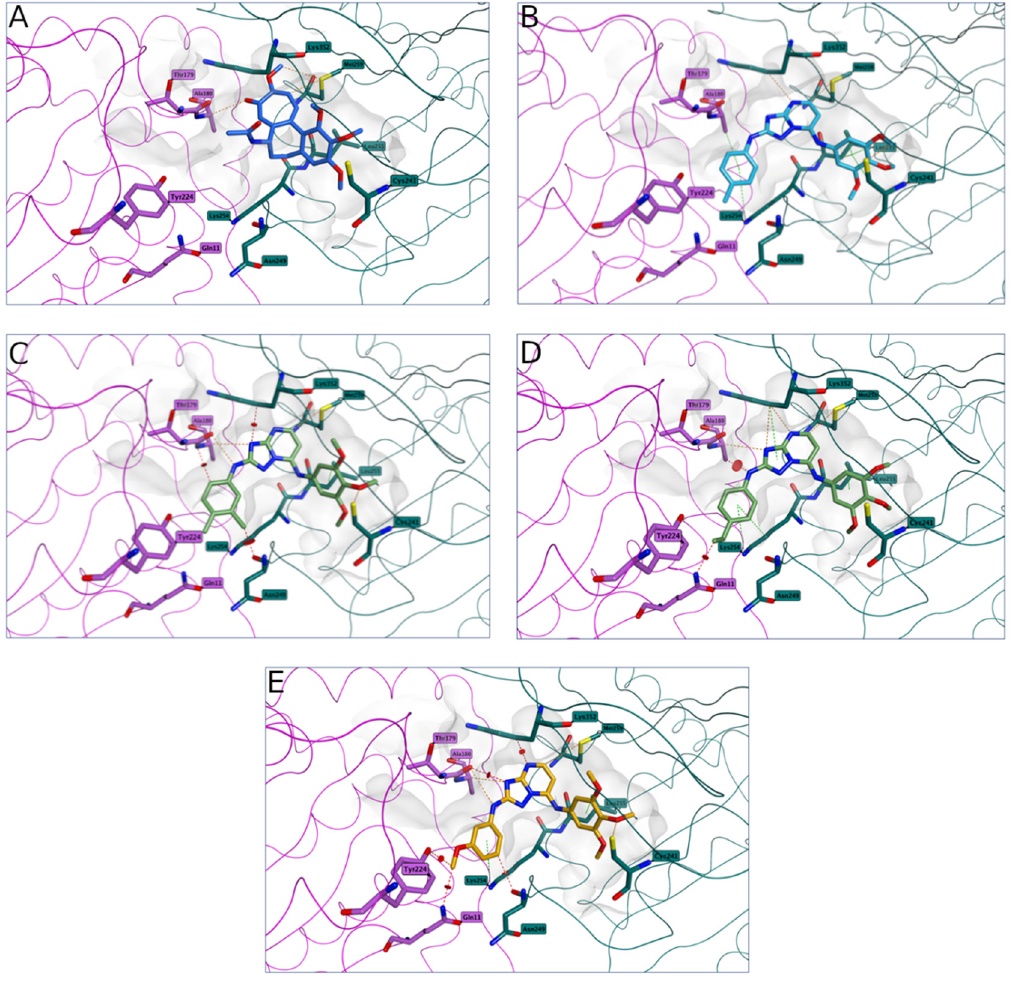
Figure 3. Colchicine binding conformation ( A ) and proposed binding for compounds 3d ( B ), 3f ( C ), 3h ( D ) and 3l ( E ) in the colchicine site. All the derivatives presented the trimethoxyphenyl ring in proximity to β Cys241, while the substituted phenyl group at position 2 of the central core was sited at the interface between the two tubulin subunits, pointing toward a loop in the α -subunit ( α Ser178- α Thr179). Compound 3d presented two main interactions with β Cys241, different anchoring contacts with the surrounding residues and no clashes with the tubulin structure. The rest of the compounds, even if conserving different interactions, including the important interaction with β Cys241, presented different clashes with the surrounding residues, suggesting a non-optimal occupation of the colchicine site and indicating a reduced affinity for tubulin. The carbon atoms of the tubulin α unit residues are shown in lilac, while the carbon atoms of the β unit residues are represented in teal. Hydrogen bonds are shown as orange dashed lines, hydrophobic interactions as green dashed lines and distance clashes as red dashed lines.